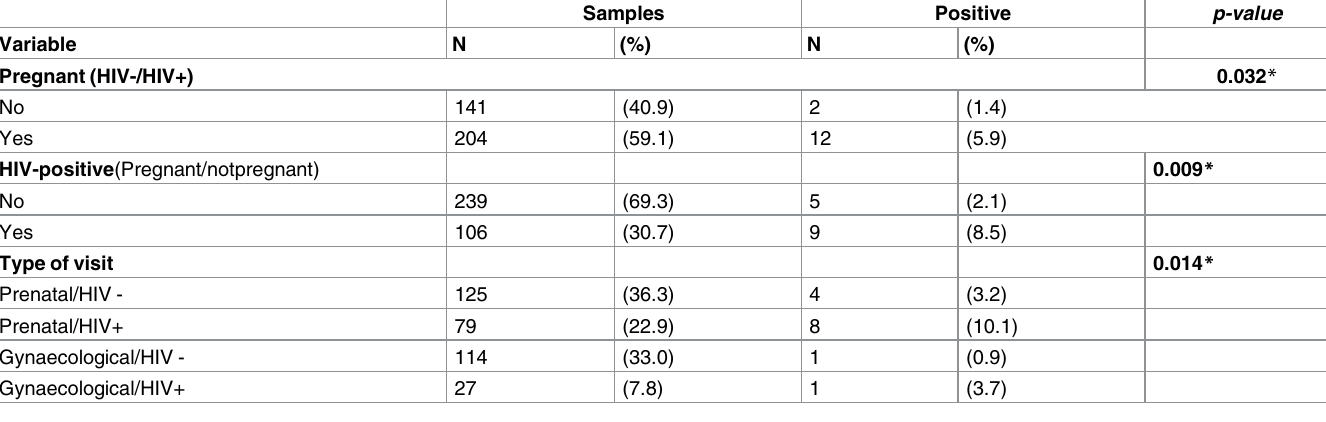
Table 1. Bivariate analysis of T . vaginalis diagnosis in women via polymerasechain reaction (PCR) using the TVK3/7 primer set, considering the variables pregnancy and HIV infection. Gynaecology and Obstetrics Service of the University Hospital of Rio Grande, Rio Grande do Sul, Brazil, January 2012 to January2015 (n =